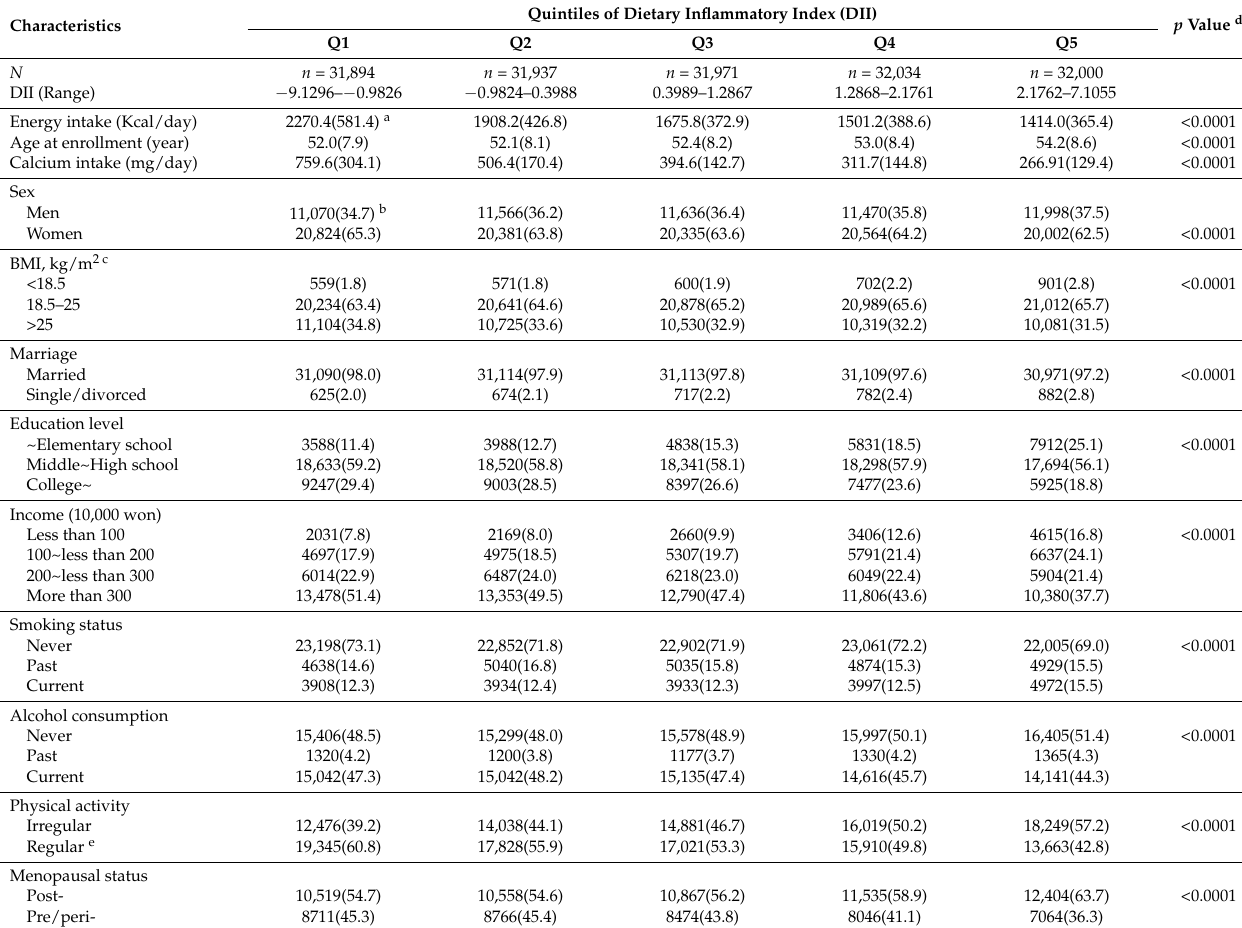
Table 1. Baseline characteristics of participants by dietary inflammatory index (DII) quintiles in the KOGES cohort, 2001~2016.